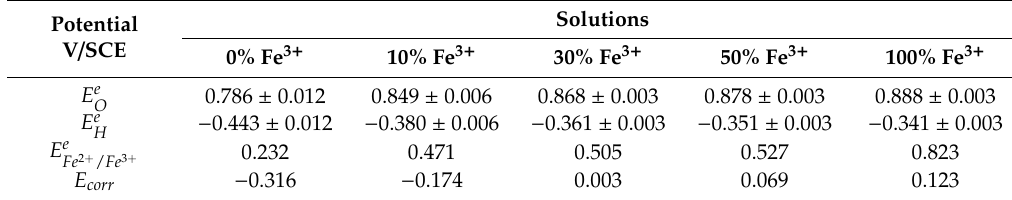
Table 3. Equilibrium electrode potential of cathodic reduction and self-corrosion potential of